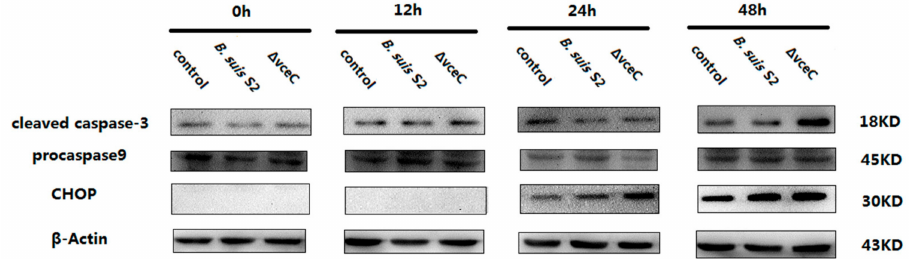
Figure 3. E ff ect of deletion of VceC on apoptosis of Brucella following infection of GTCs. GTCs